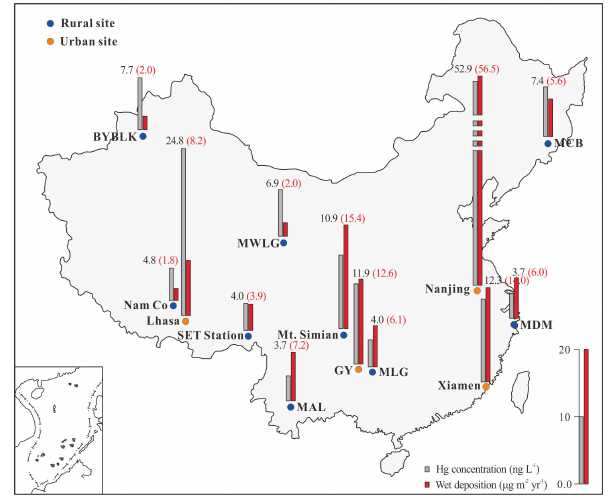
Figure 4. Annual VWM Hg concentrations in precipitation and wet deposition fluxes of Hg in this study and the literature (Huang et al., 2012, 2013, 2015; Xu et al., 2014; Zhu et al., 2014; Ma et al., 2016). Black and red values above the columns correspond to VWM concentration and wet deposition of Hg,